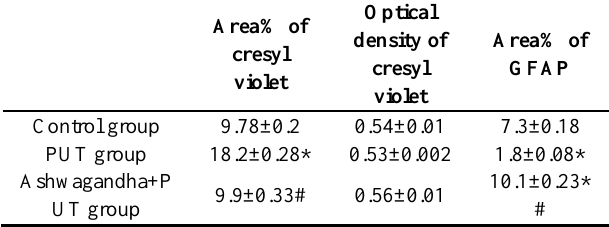
Table 4: Mean±SE area% and optical density of cresyl violet stain and area % of GFAP in dentate gyrus in the studied groups Control group